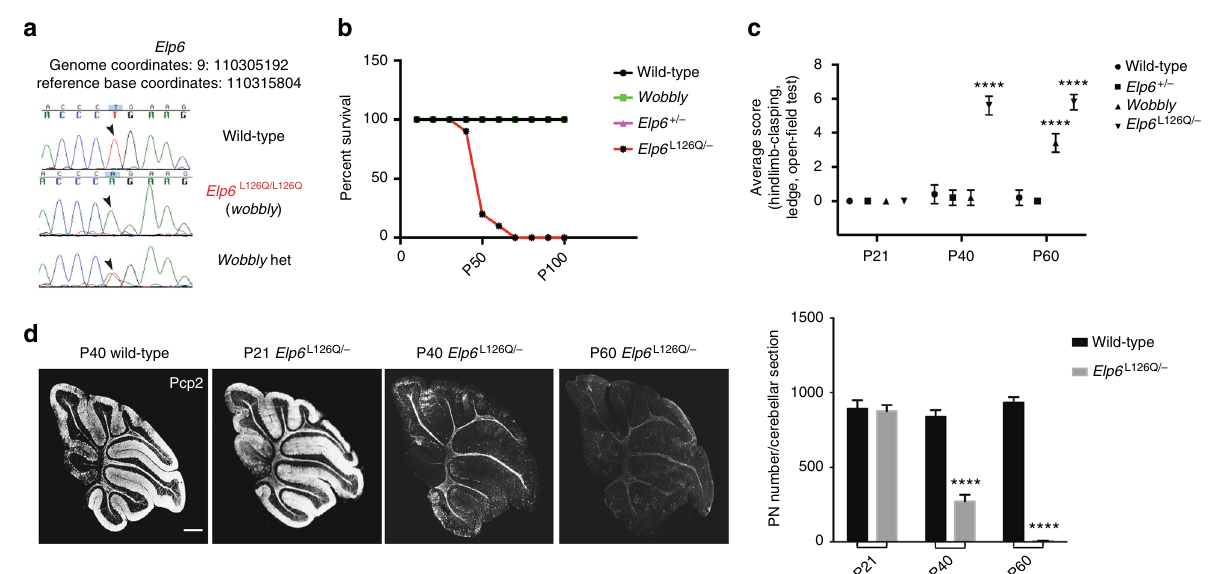
Fig. 2 The wobbly mutation is identi fi ed in the Elp6 gene. a Sequencing chromatograms showing the Elp6L126Q mutation. Arrowheads indicate the affected nucleotide. b Survival rates of wild-type, wobbly , Elp6 + / − and Elp6 L126Q/ − mice ( n = 30 animals for each of the genotypes). c Ataxic phenotype scoring of wobbly and Elp6 L126Q/ − mice relative to wild-type ( n = 6 (3 males and 3 females) for each of the genotypes). d Pcp2 immuno-labeling and quanti fi cation of PNs in Elp6 L126Q/ − and control animals ( n = 5 for each of the genotypes and ages presented; representative images are shown). Scale bar: 500 μ m. Statistical evaluation: two-way ANOVA and Sidak ’ s multiple comparisons test. Statistically signi fi cant differences are indicated ( **** P ≤ 0.0001). Data represent mean ±